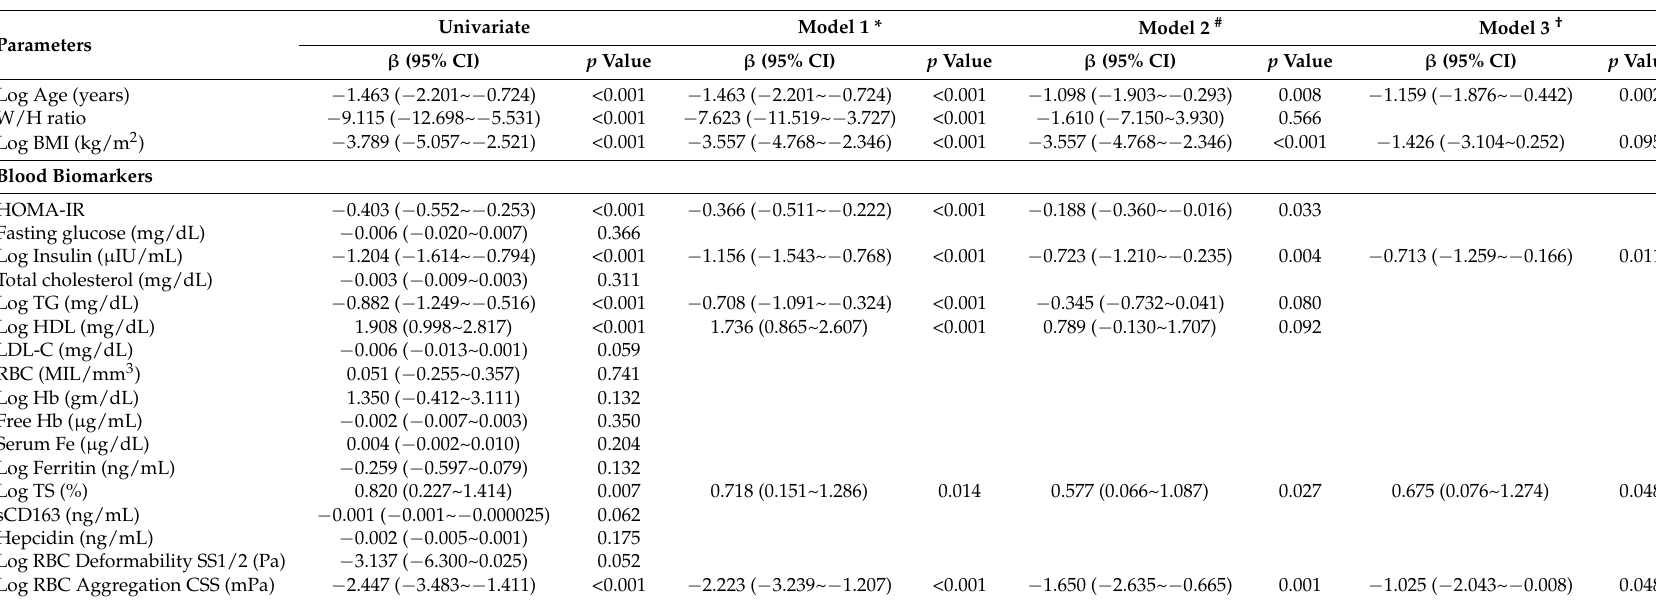
Table 2. Multivariate linear regression of serum total testosterone levels and selected anthropometric, inflammation, lipid, glucose, and iron-related biomarkers.